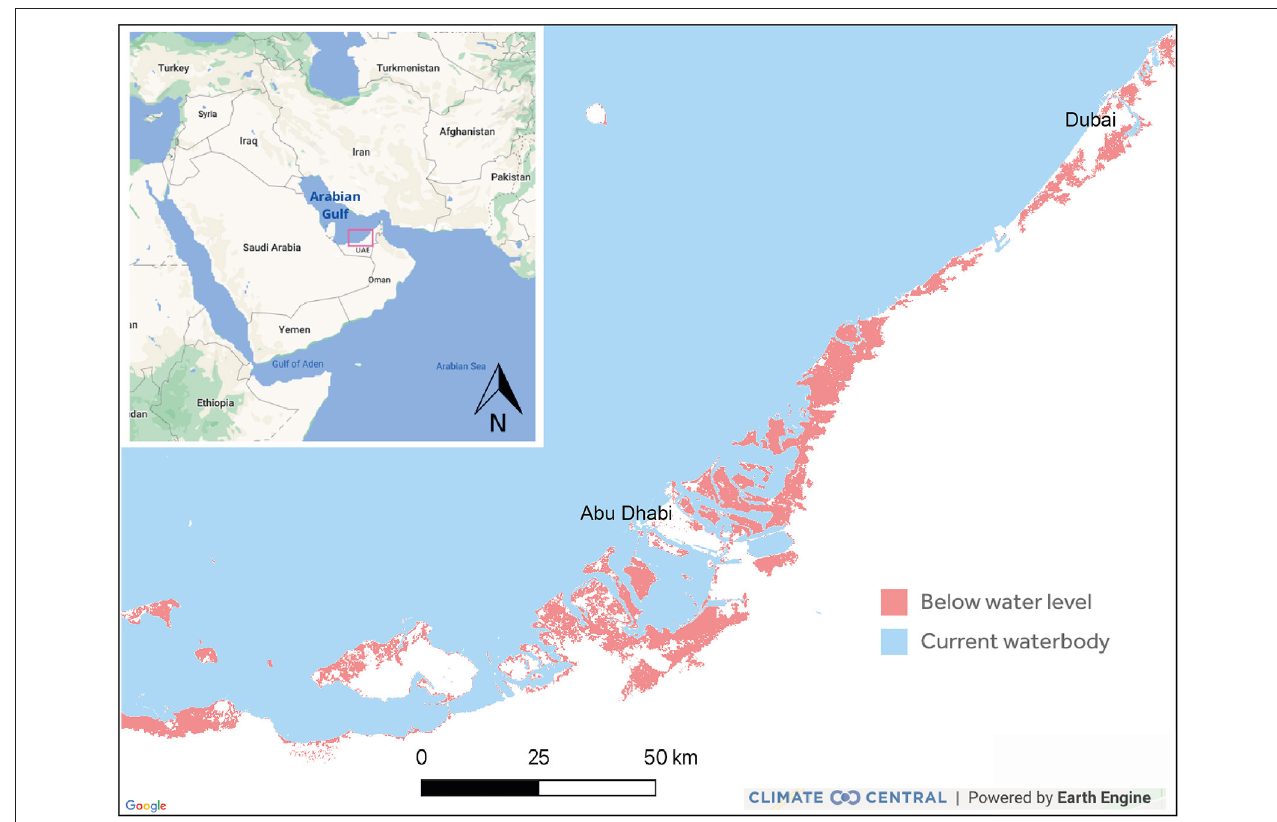
FIGURE 1 | Extent of projected Sea-Level Rise for two major cities in the UAE from Climate Central CoastalDEM (Kulp and Strauss, 2019). Red shading shows regions expected to experience flooding by 2100 under a moderate 2 ◦ Celsius warming scenario (RCP 4.5) and a Kopp et al. (2014) mid-range